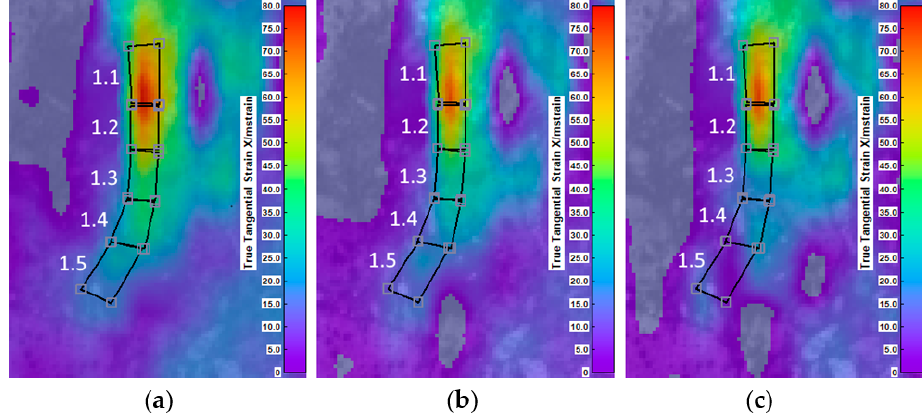
Figure 6. Horizontal strain of specimen S1 at the end of step 1 ( left ), and the mean horizontal strain of five selected areas( right ), the vertical dash-dot line shows the stopping moment of step 1 and start of step 2.